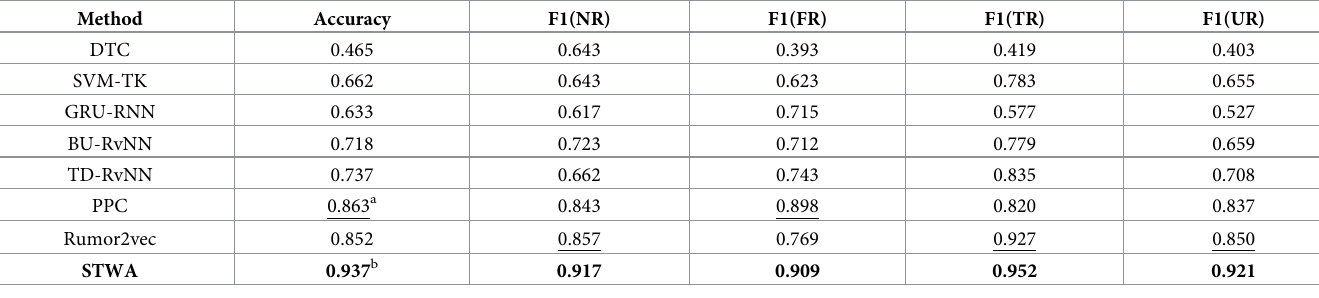
Table 3. Overall performance comparison of rumor detection on